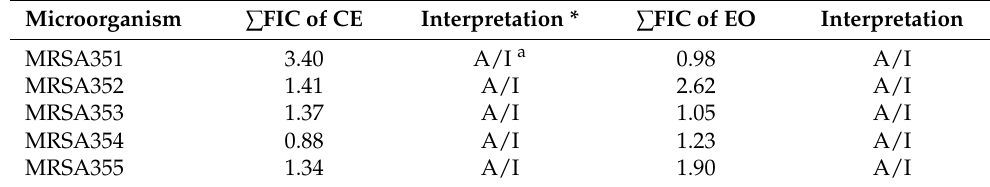
Table 5. The combination effects of ciprofloxacin with CE or EO against the MRSA. Microorganism ∑ FIC of CE Interpretation * ∑ FIC of EO Interpretation MRSA351 3.40 A/I a 0.98 A/I MRSA352 1.41 A/I 2.62 A/I MRSA353 1.37 A/I 1.05 A/I MRSA354 0.88 A/I 1.23 A/I